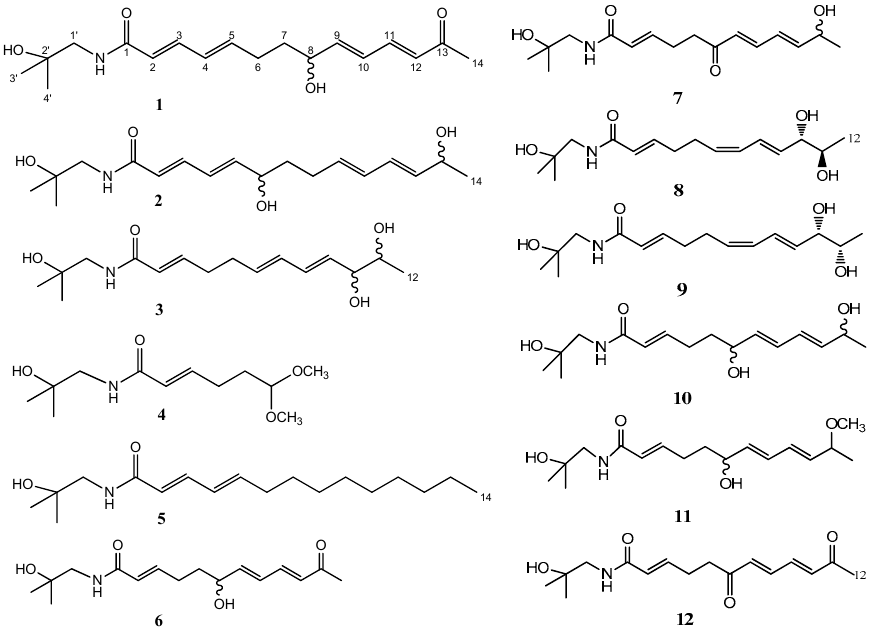
Figure 1. Chemical structures of compounds 1 – 12 .